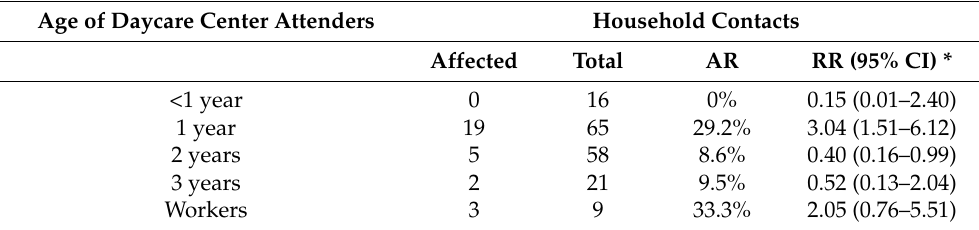
Table 4. Attack rates and risk ratios of household contacts by the age of child attenders. Age of Daycare Center